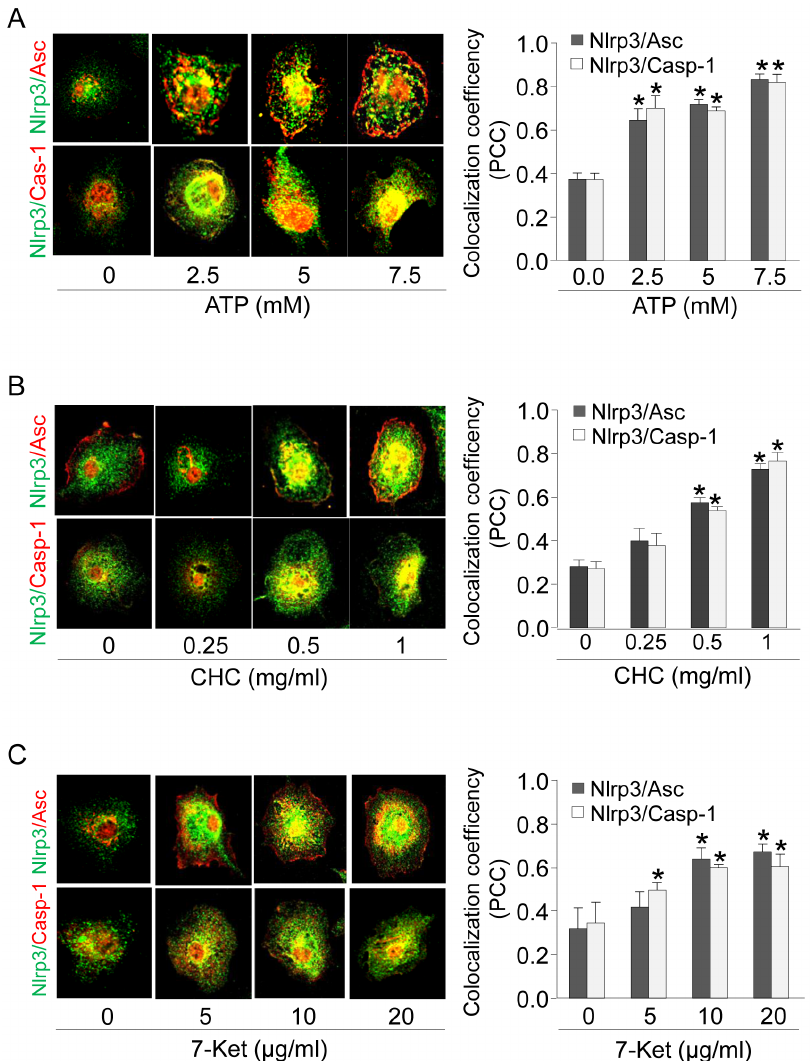
Figure 1. ATP, cholesterol crystal or 7-ketocholesterol increased inflammasome formation in Asc + / + BMMs. (A) Representative confocal fluorescence images and summarized data depicting the effect of ATP (0–7.5 mM, 16 h) on the colocalization between Nlrp3 and Asc or caspase-1 in Asc + / + BMMs. (B) Representative confocal fluorescence images and summarized data depicting the effect of cholesterol crystal (0–1 mg/ml, 16 h) on the colocalization between Nlrp3 and Asc or caspase-1 in Asc + / + BMMs. (C) Representative confocal fluorescence images and summarized data depicting the effect of 7-ketocholesterol (0–20 m g/ml, 16 h) on the colocalization between Nlrp3 and Asc or caspase-1 in Asc + / + BMMs. * P , 0.05 vs. untreated control group